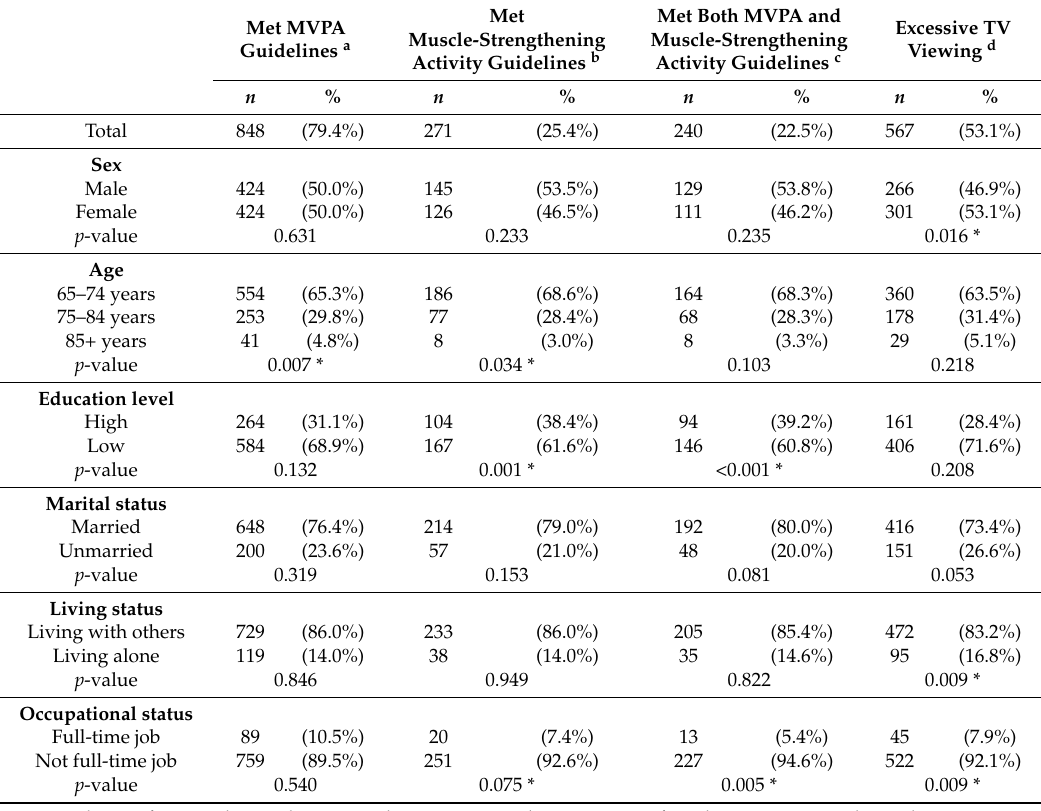
Table 1. Prevalence of meeting moderate to vigorous-intensity physical activity (MVPA) guidelines, muscle-strengthening (MS) activity guidelines b , combined MVPA–MS activity guidelines c , and engaging in excessive TV viewing d by sociodemographic